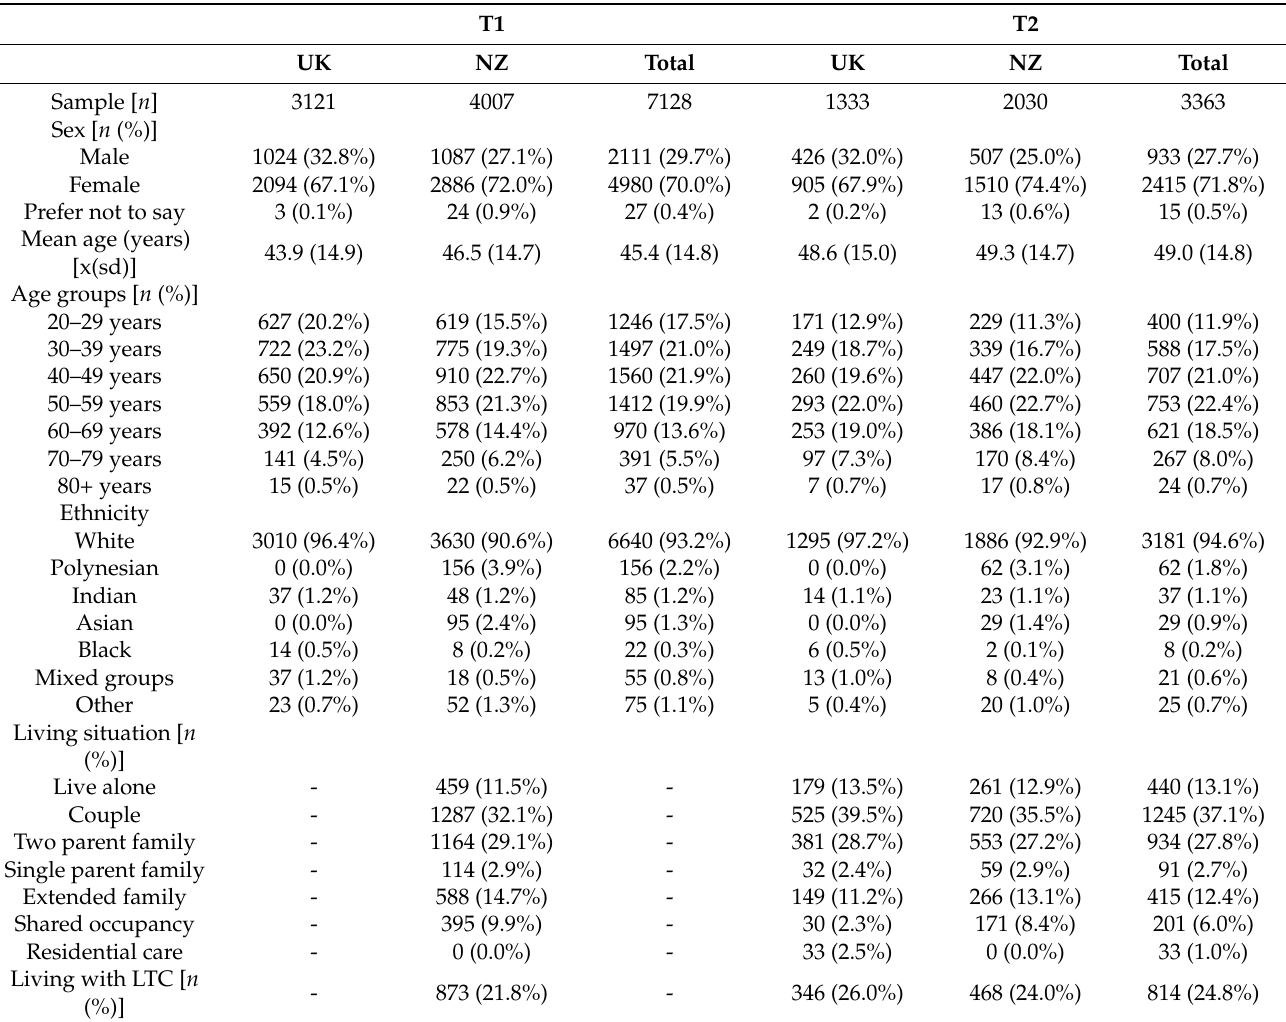
Table 1. Population characteristics by country for Survey 1 (T1) and 2